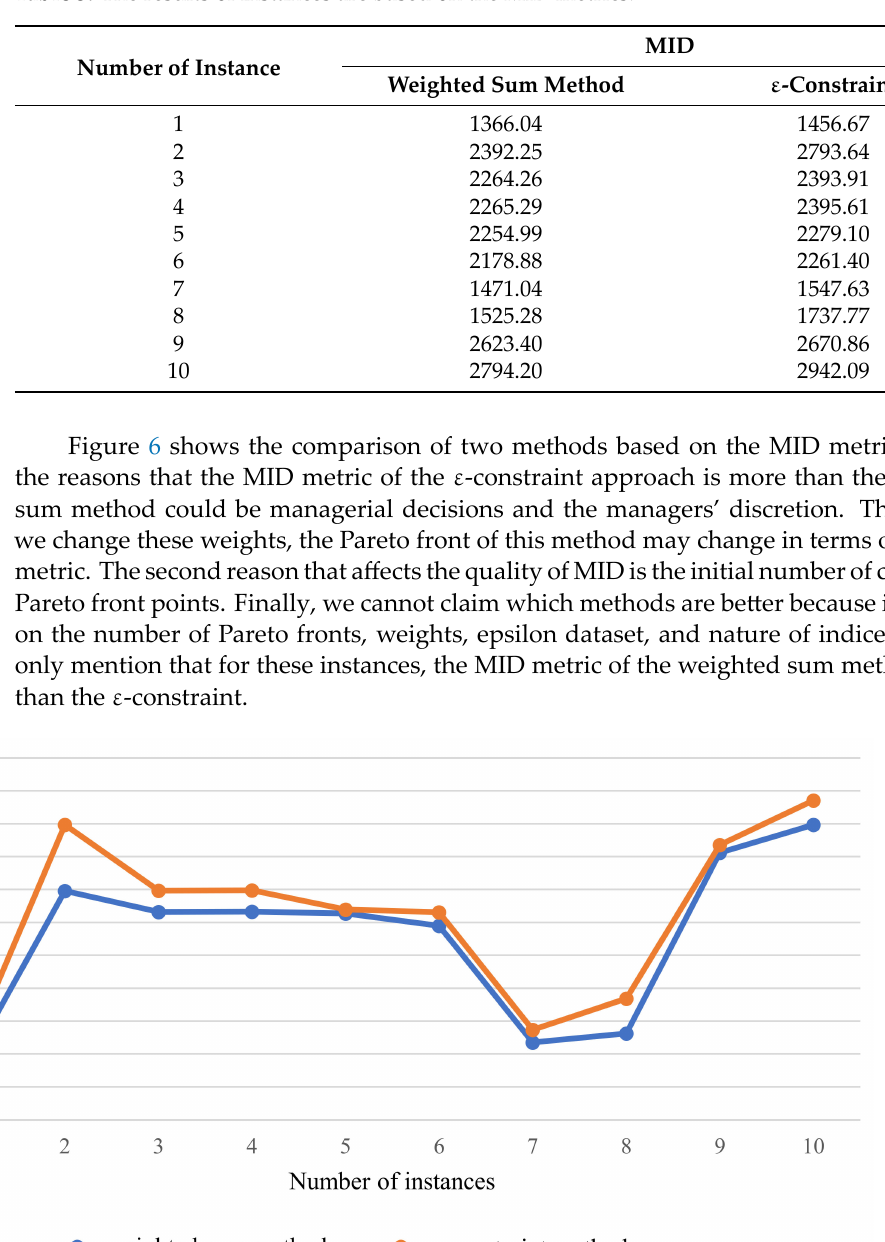
Table 5. The results of instances are based on the MID metrics.